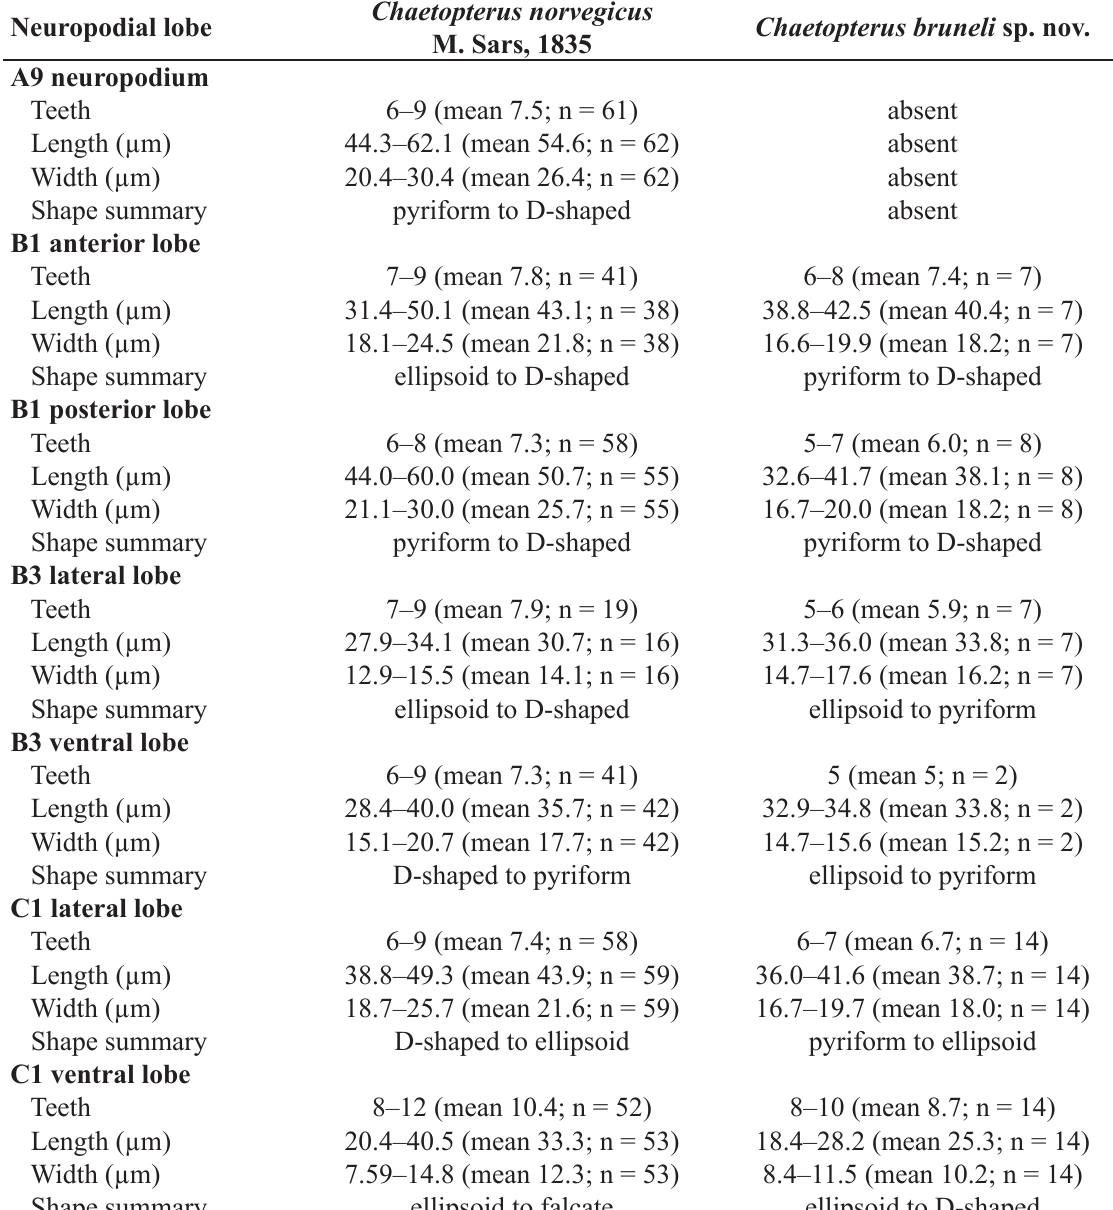
Table 2. Comparison of uncini measurements and tooth counts for Chaetopterus norvegicus M. Sars, 1835 and C. bruneli sp.